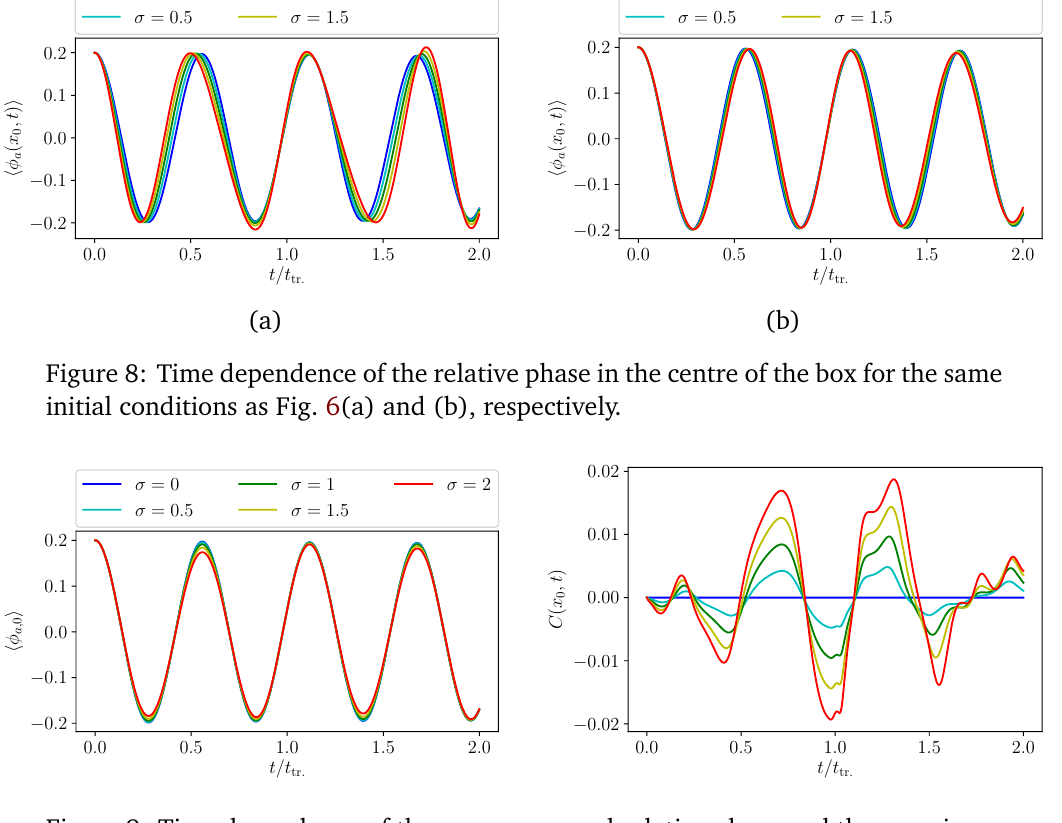
Figure 9: Time dependence of the space-averaged relative phase and the covariance C ( x , t ) (82) in the centre of the box for the profiles shown in panel (a) of Fig. 0